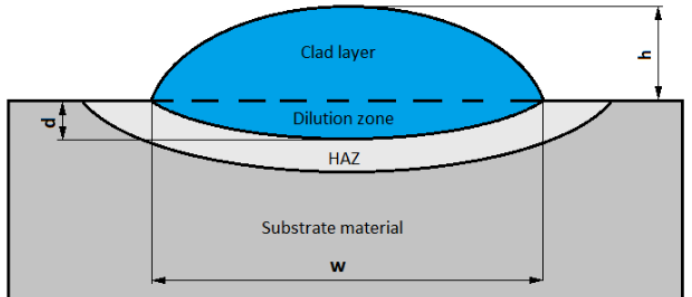
Figure 6. Diagram showing geometrical parameters of a laser cladded single bead: height (h), depth (d), width (w).